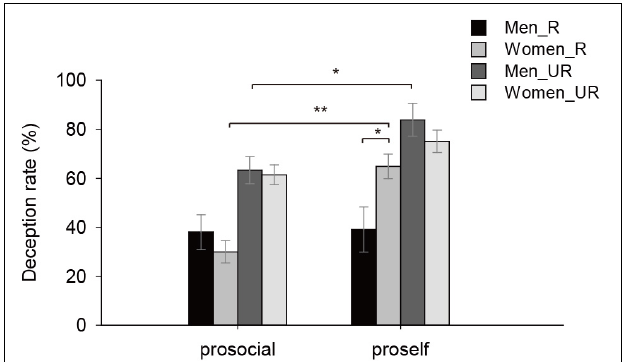
FIGURE 4 | Gender difference in Experiment 2. Proself men deceived less than proself women in the R condition, and deceived more than prosocial men in the UR condition. ( ∗∗ p < 0.01, ∗ p <